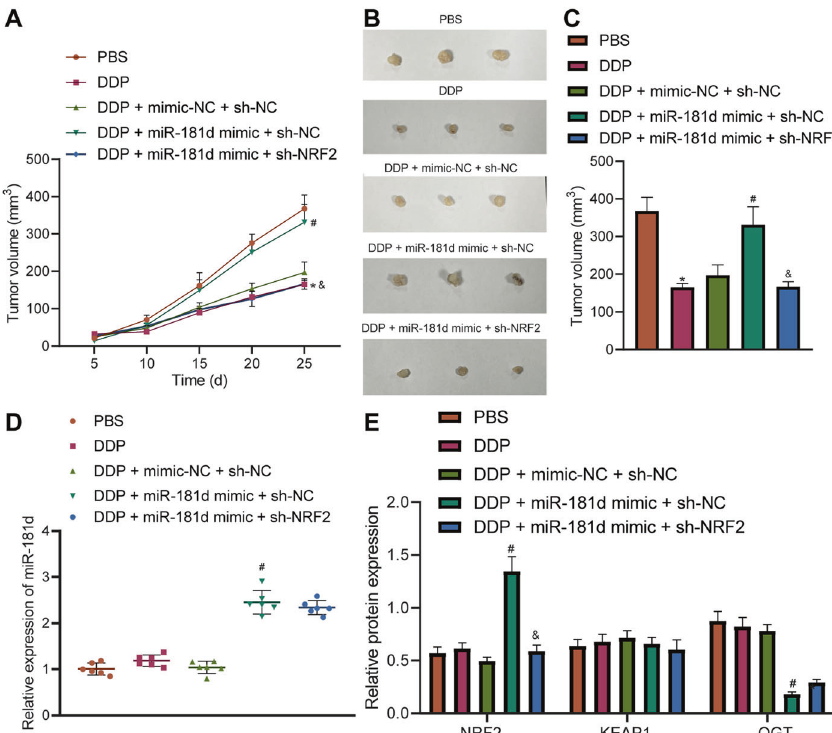
Fig. 7 miR-181d regulates the OGT/KEAP1/NRF2 axis to promote OC Resistance to DDP in vivo. A2780 cells stably transfected with mimic- NC + sh-NC, miR-181d mimic + sh-NC or miR-181d mimic + sh-NRF2 and untreated A2780 cells were xenografted subcutaneously into the DDP-treated nude mice. A Tumor volume of nude mice measured at 5, 10, 15, 25 days after cell injection. B Representative images showing xenografts in nude mice. C Quantitative analysis of panel B . D RT-qPCR detection of miR-181d expression in tumor tissues of nude mice normalized to U6. E Western blot assay of the expression and quantitative analysis of NRF2, KEAP1, and OGT proteins in nude mouse tumor tissues normalized to β -actin. * p < 0.05 versus nude mice treated with PBS. # p < 0.05 versus nude mice treated with DDP + mimic-NC + sh-NC. & p < 0.05 versus nude mice treated with DDP + miR-181d mimic + sh-NC. n = 6 for nude mice in each